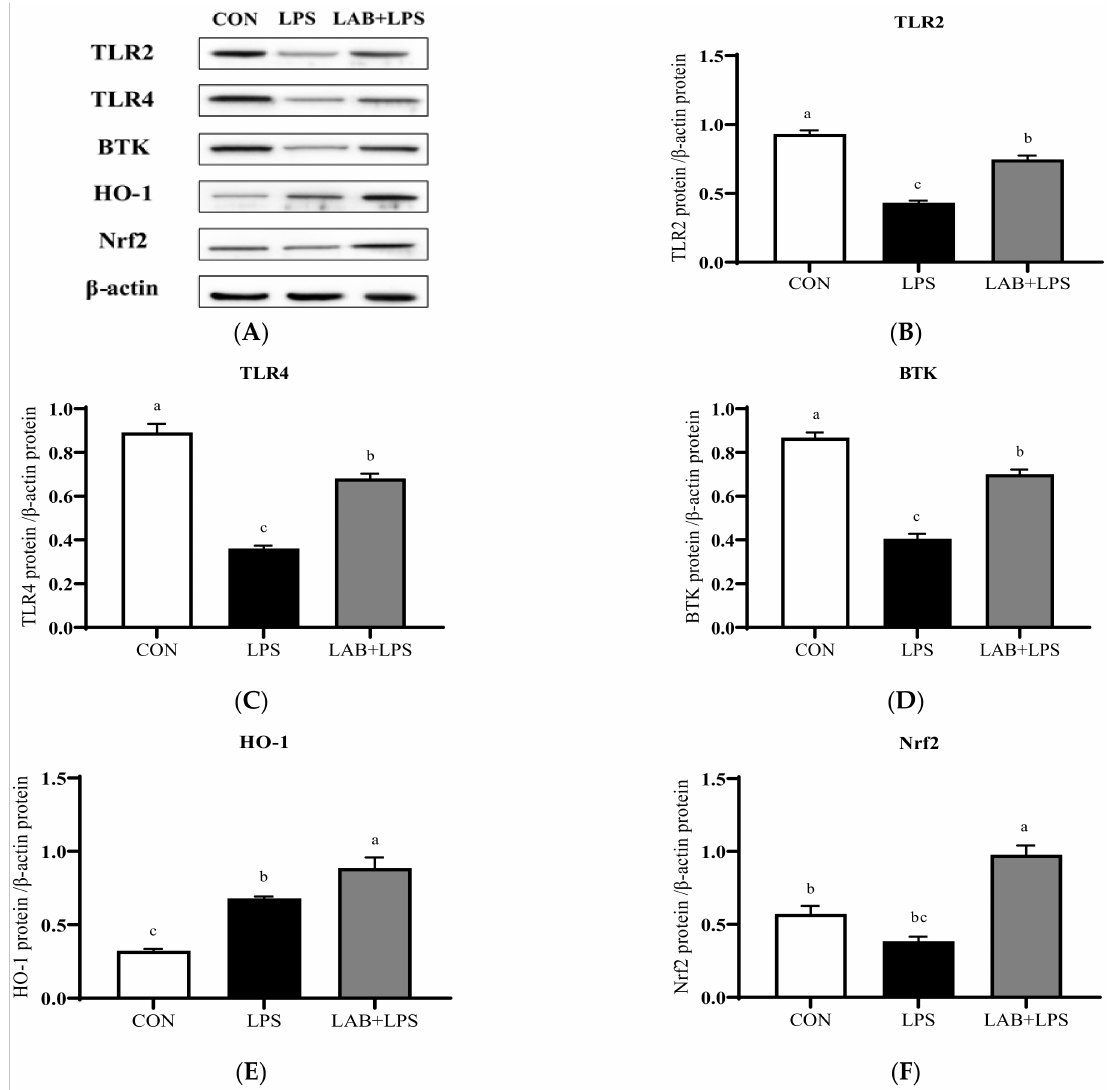
Figure 3. The effects of LAB supplementation on the protein expression of TLRs, Btk, and Nrf2 in the jejuna of weaned piglets. Expression based on Western blotting ( A ) and quantification for ( B ) TLR2, ( C ) TLR4, ( D ) Btk, ( E ) HO-1, and ( F ) Nrf2. Data are presented as means ± SEMs ( n = 6). a,b,c Mean values within a row with different superscript letters indicate significant differences ( p < 0.05). CON—non-challenged piglets fed a basal diet; LPS—LPS-challenged piglets fed a basal diet; LAB + LPS—LPS-challenged piglets fed a basal diet supplemented with 0.2% LAB. TLR2—Toll-like receptor 2; TLR4—Toll-like receptor 4; BTK—Bruton’s tyrosine kinase; HO-1—hemeoxygenase-1; Nrf2—nuclear factor erythroid 2-related factor